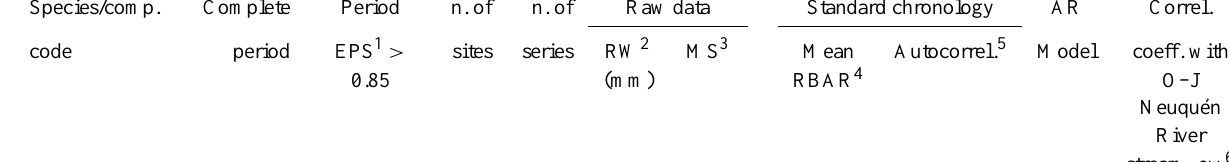
Table 1. Descriptive statistics for composite chronologies. Species/comp.